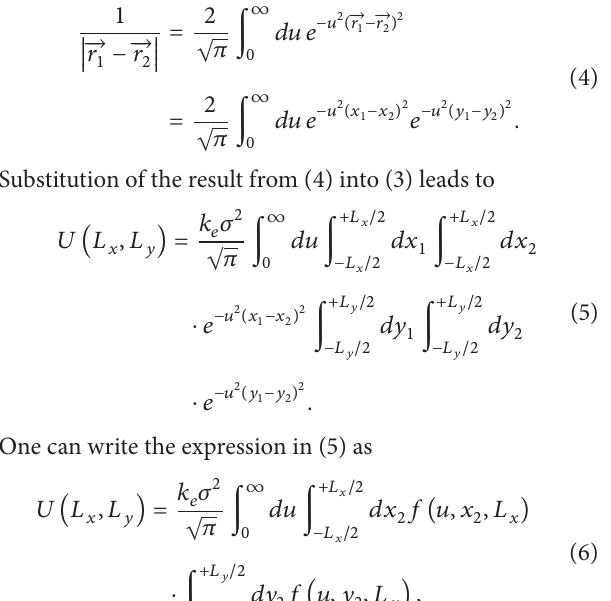
󳨀→ 𝑟 = (𝑥 , 𝑦 ) ( 𝑖 = 1, 2 𝑖 𝑖 𝑖